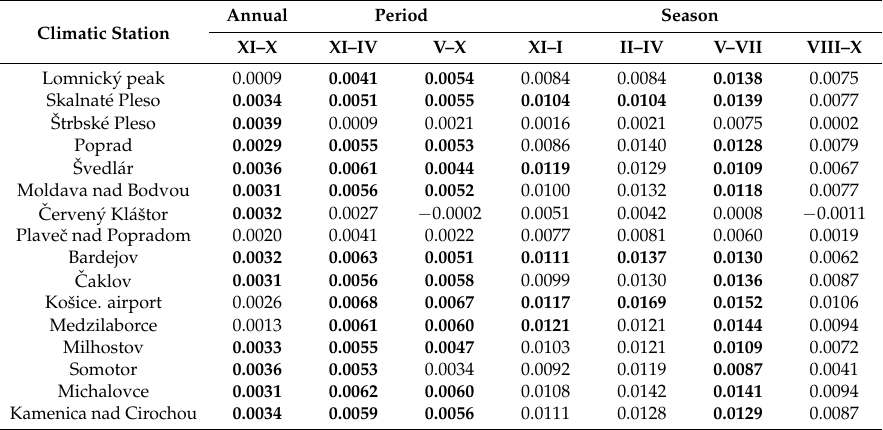
Table 4. Annual and seasonal temperature trends in climatic stations.